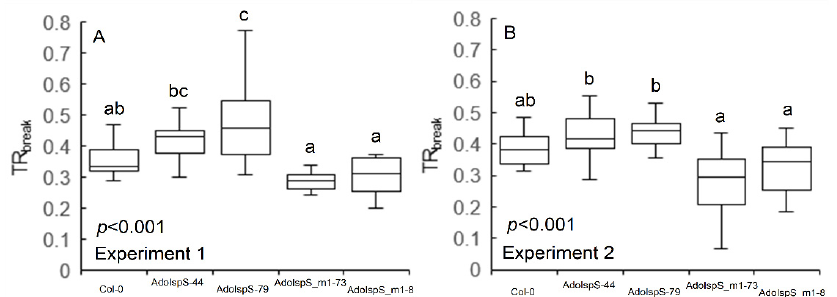
Figure 4. Breakpoint of plant transpiration to reduced soil water availability (TR break ). Data were gravimetrically collected in Experiment 1 ( A ) and 2 ( B ) and daily plant transpiration was plotted against FTSW curves and subjected to segmented regression ( n = 10 in A and n = 12 in B). Data were analyzed with one-way ANOVA and different letters represent significant differences according to Fisher’s test.